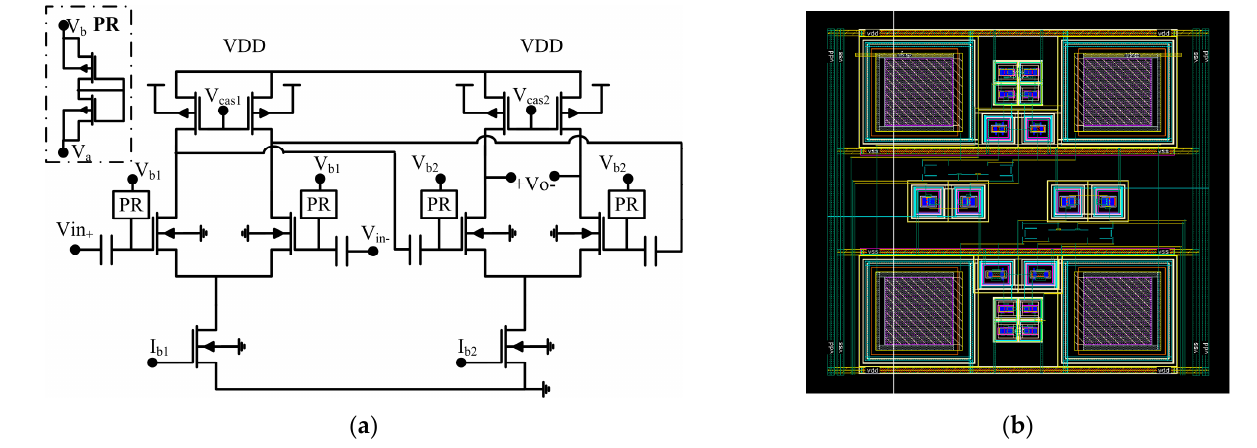
Figure 13. ( a ) Intermediate-frequency amplifier architecture. ( b ) Layout.